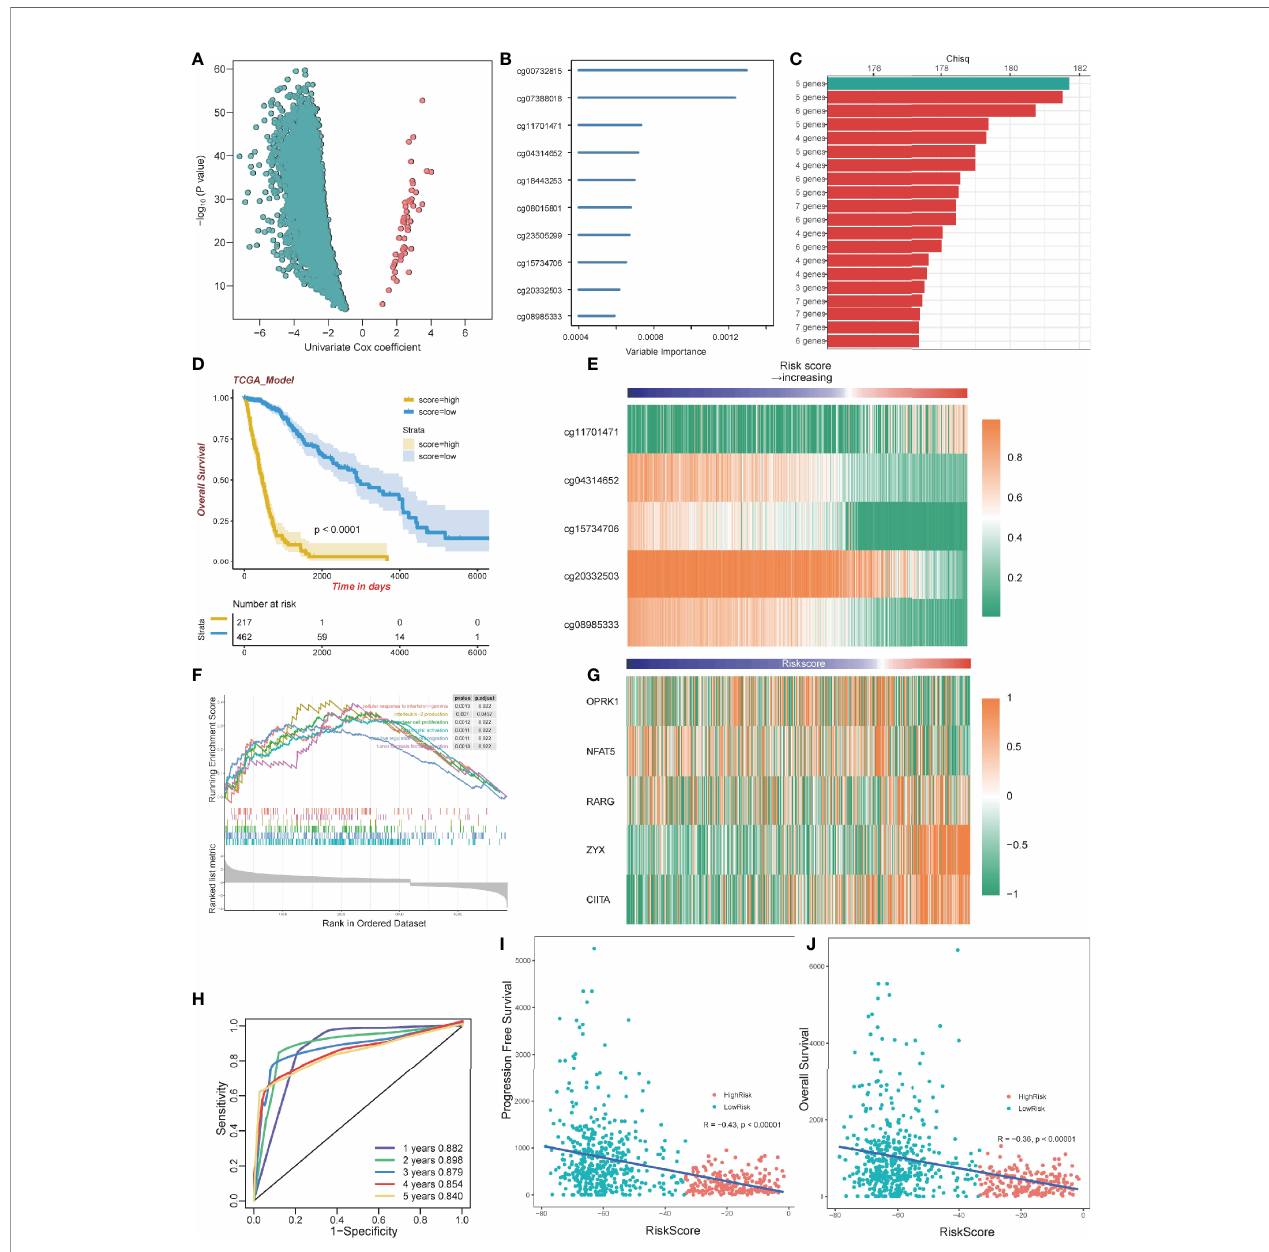
FIGURE 5 | Construction of a prognostic model. (A) Volcano plot showing the selected probes by univariate Cox regression analysis. The horizontal axis represents log2(HR) (B) Variable importance of 10 probes determined by random survival forest analysis. (C) Top 20 combinations of signatures were selected after Kaplan – Meier analysis according to the chi-square value. A fi ve-probe signature with the highest chi-square was identi fi ed. All 20 signatures had a signi fi cant p-value Kaplan – Meier analysis. (D) Kaplan – Meier analysis of the high-risk and low-risk group. (E) Heatmap of the fi ve selected methylation probes sorted by risk score. (F) GSEA plots for the enrichment of immunogenic and oncogenic signaling pathways from the GO. (G) Heatmap of gene expression corresponding to the selected fi ve probes sorted by risk score. (H) ROC curve of the TCGA dataset. (I) The correlation between PFS time and risk score. (J) The correlation between OS time and risk